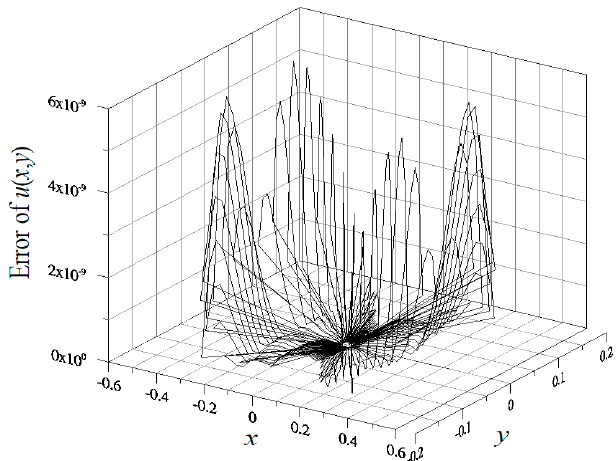
Figure 13. The numerical errors of proposed method solution for the steady-state AC equation with a peanut-shaped domain.